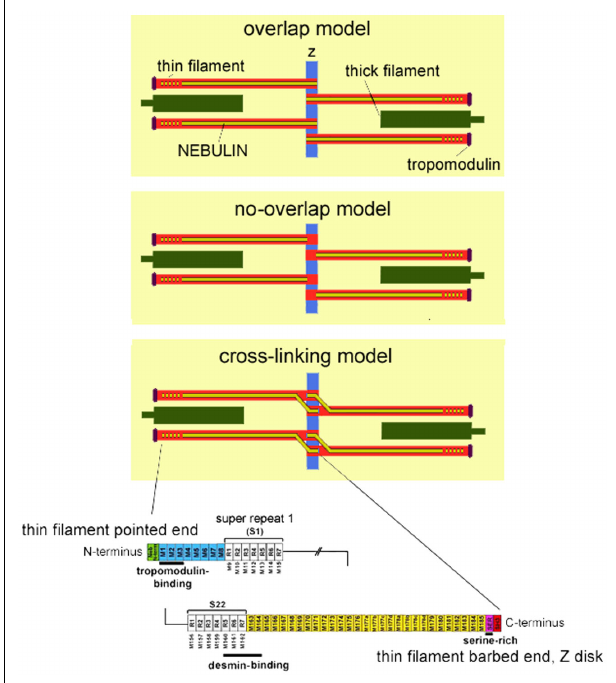
FIGURE 1 |Top:Three schematics of the skeletal muscle sarcomere depicting the three proposed models of nebulin in the Z-disk: the overlap model in which nebulin penetrates the Z-disk creating a ∼ 75nm wide nebulin overlap zone in the center of the Z-disk; the no-overlap model in which nebulin penetrates the Z-disk by only about 25nm, and nebulin filaments from neighboring sarcomeres do not overlap; the cross-linking model in which nebulin fully penetrates the Z-disk and cross-links thin filaments from adjacent sarcomeres. Also note that a single nebulin molecule spans most of the length of the thin filament, but that according to recent studies the thin filament pointed-end is nebulin-free.The length of the nebulin-free thin filament extension is variable (as indicated in the drawing by the dotted nebulin filament) and depends on species and muscle type. Bottom: Schematic of the human nebulin sequence. Nebulin has a highly modular structure, with in the central region (M9–M162) seven modular repeats arranged into 22